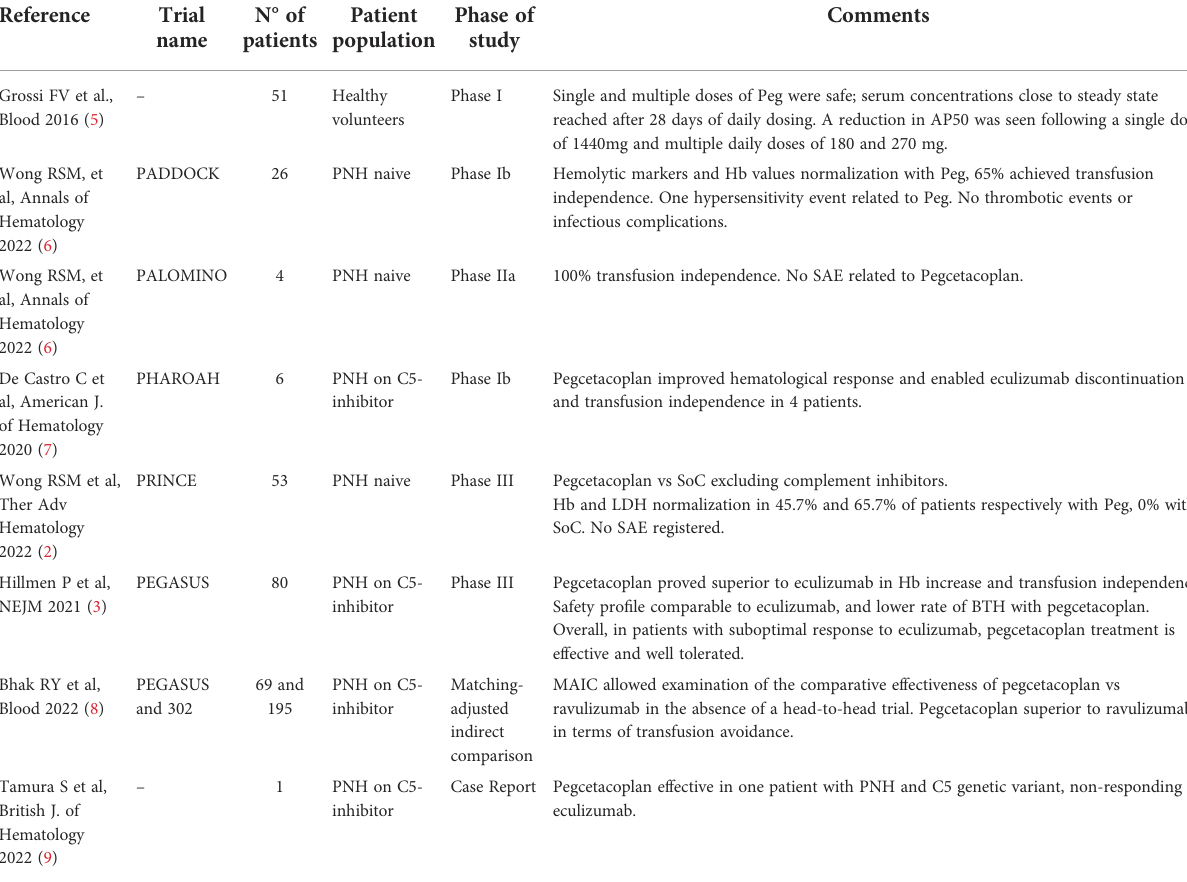
TABLE 1 Literature review regarding pegcetacoplan use in paroxysmal nocturnal